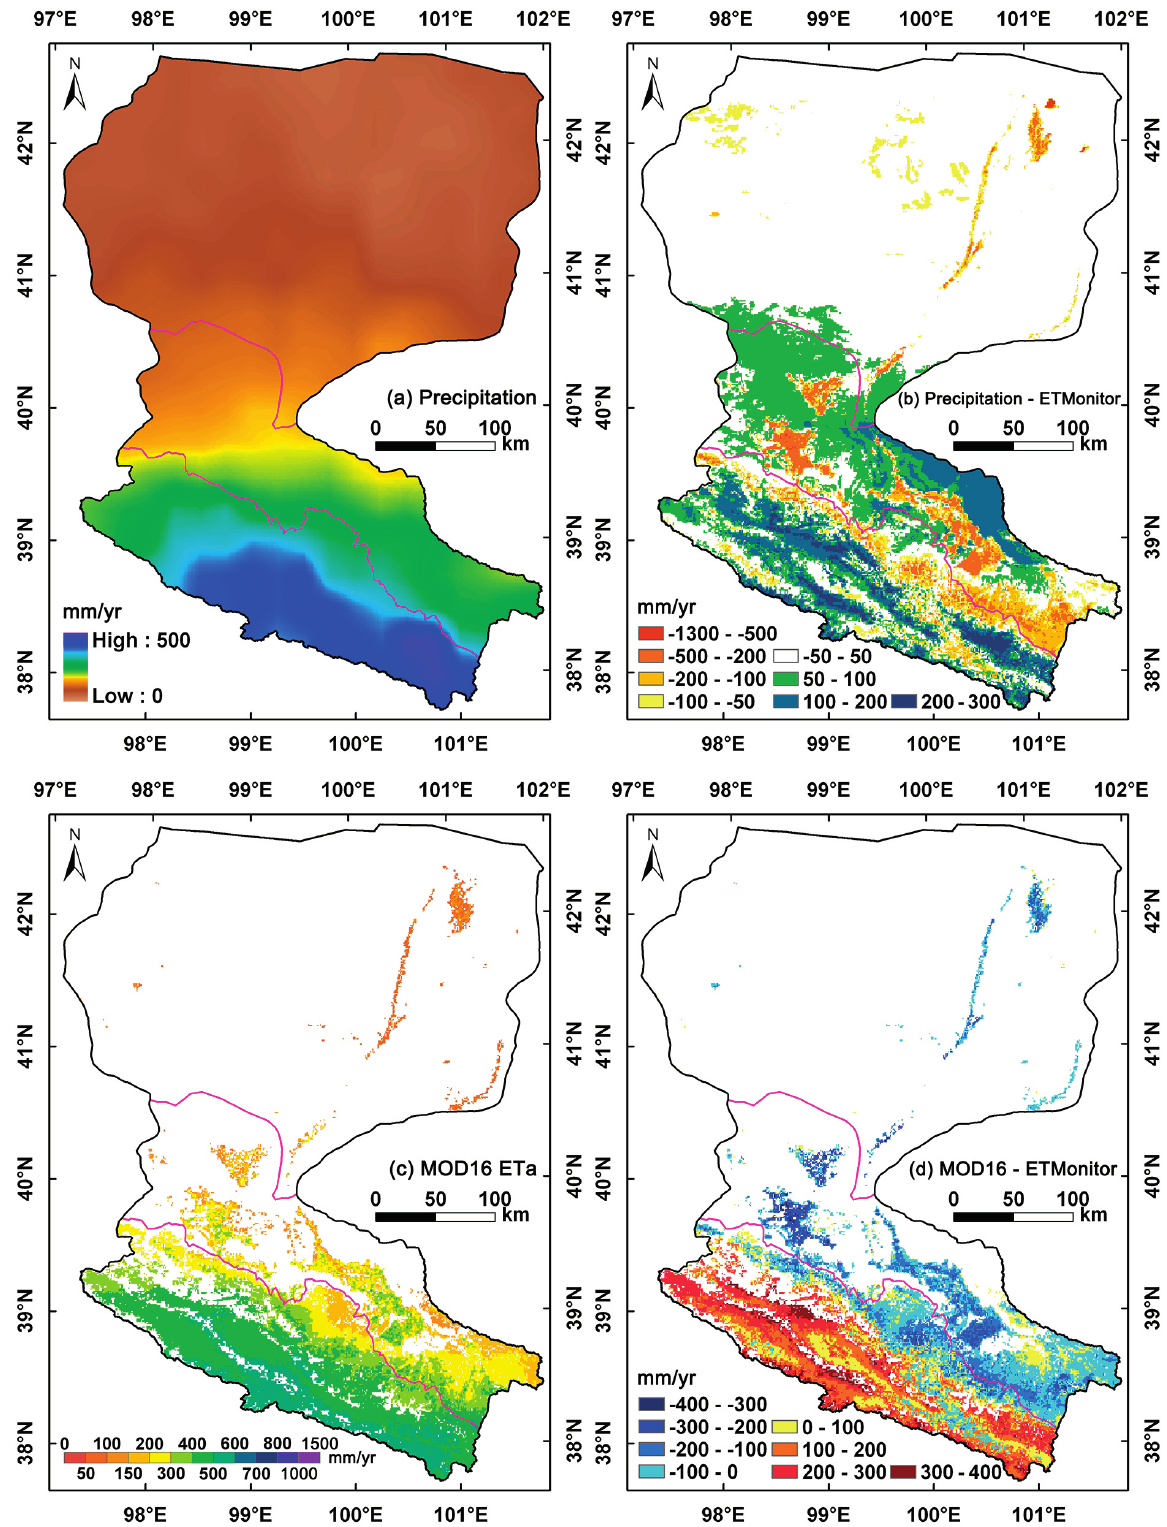
Figure 7. Spatial comparisons of the annual ETMonitor evapotranspiration (ETa) in 2010 with ( a ),( b ) Tropical Rainfall Measuring Mission (TRMM) precipitation and ( c ),( d ) MOD16 ETa in the Heihe River basin. In (c) and (d), the regions in white are sparsely vegetated and non-vegetated